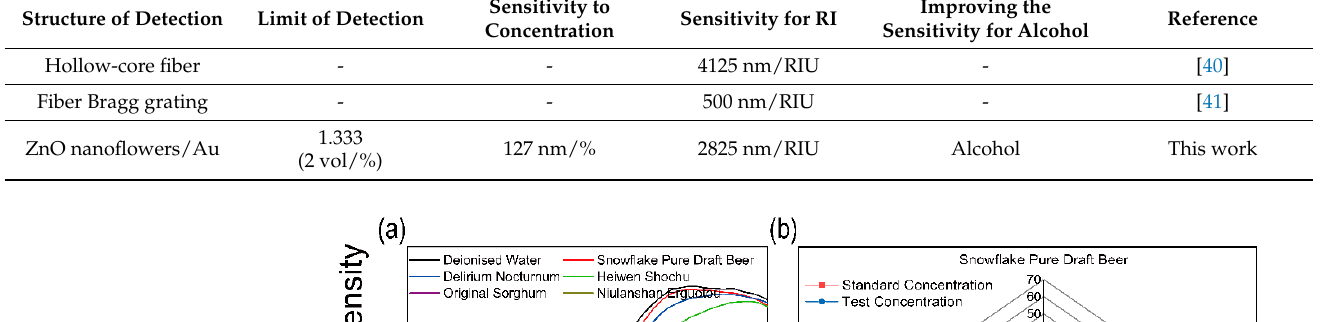
Table 2. Comparison of performance of three sensors.